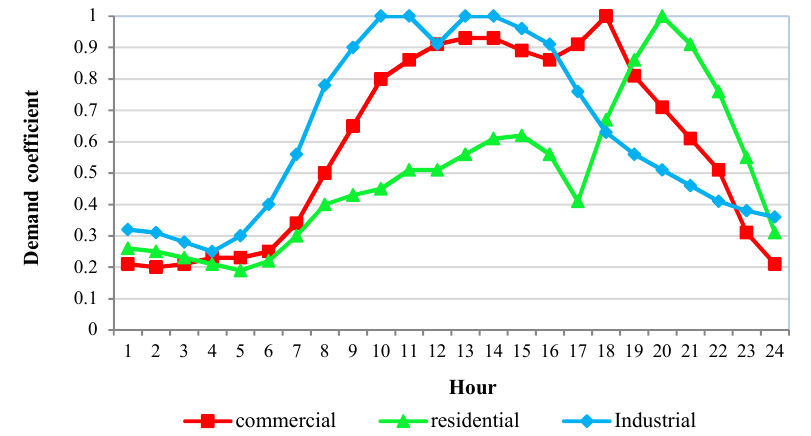
Figure 3. Average sun radiation annual data.